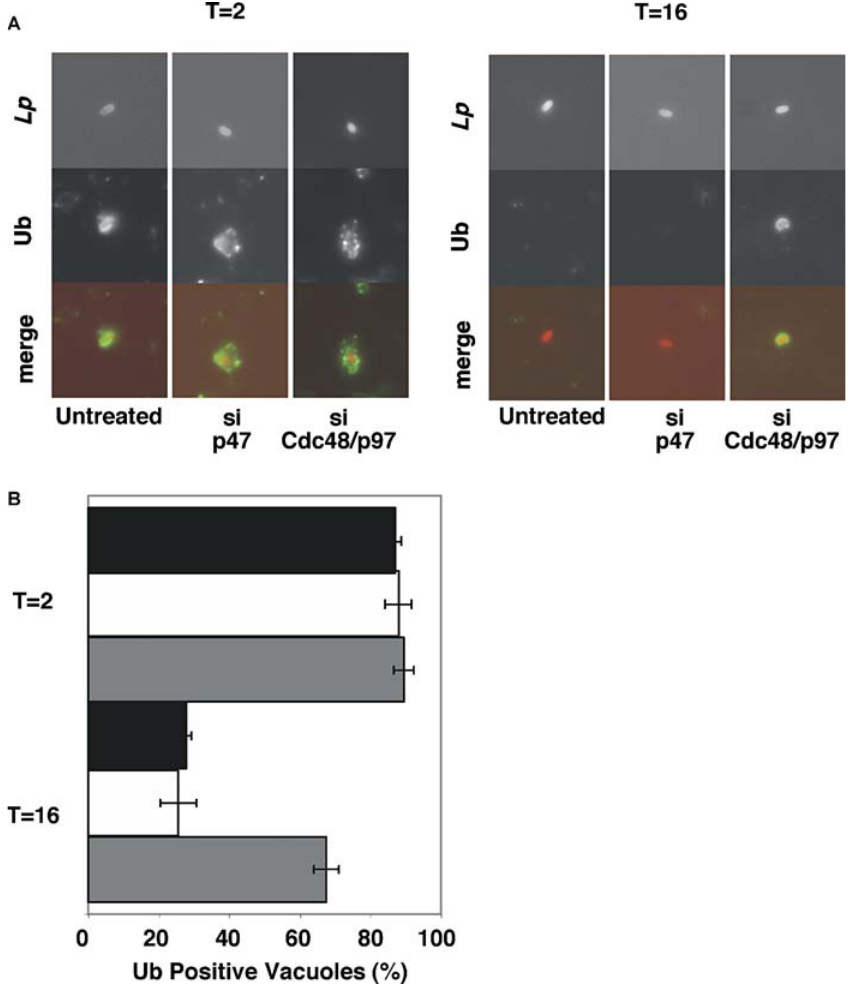
Figure 6. Cdc48/p97 Removes Polyubiquitinated Proteins from the Replication Vacuole (A) HEK 293 cells were silenced for Cdc48/p97 or p47 and incubated with wild-type L. pneumophila at MOI ¼ 5 for 2 hours in CM, washed, and fixed, or further incubated in CM for 16 h. Intact cells were immunostained for polyubiquitinated proteins and L. pneumophila. (B) Quantification of polyubiquitin positive vacuoles from (A). Untreated (black), si p47 (white), si Cdc48/p97 (gray). Mean of three replicates 6 standard error; at least 100 cells counted per